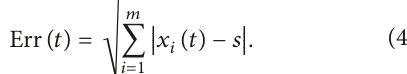
Algorithm 2 Outdegree centrality algorithm